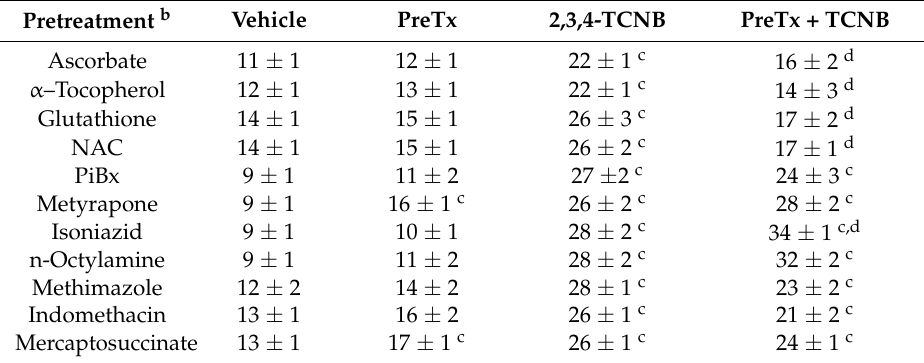
Table 2. Effect of antioxidants and metabolism inhibitors on 2,4,5-TCNB cytotoxicity a .